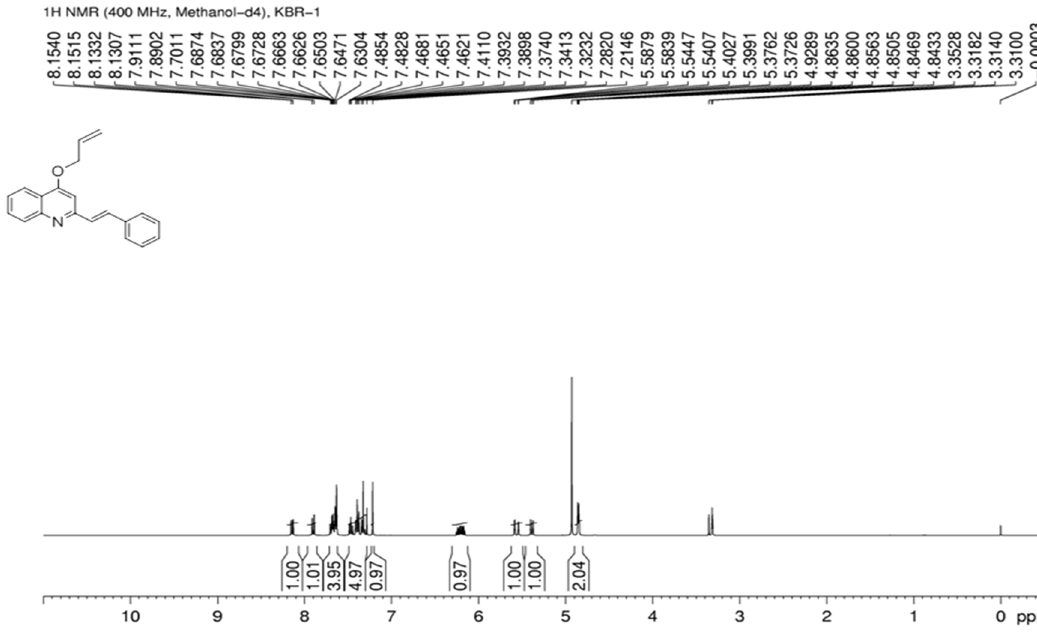
Figure 6: 1 H NMR spectrum of compound 2h in methanol - d 4 .